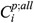
Correlation between network measures for different subgraphs (p, q).The scatter plots depict: (A) the local cross-clustering coefficient Cip;all and the cross-strength sip;out for subgraphs in the national partition: China [CHN], Germany [GER] and USA. (B) Cip;all and sip;out for the sectoral partition: Petroleum & Non-metallic products [PeT], Finance & Businesses [FiN], and Electrical & Machinery [ElE]. (C) Cip;all and the cross-betweenness bip;q in the national partition: Japan [JPN], Germany, China and USA. (D) Cip;all and bip;q in the sectoral partition: PeT, FiN, ElE and Construction [CoN].